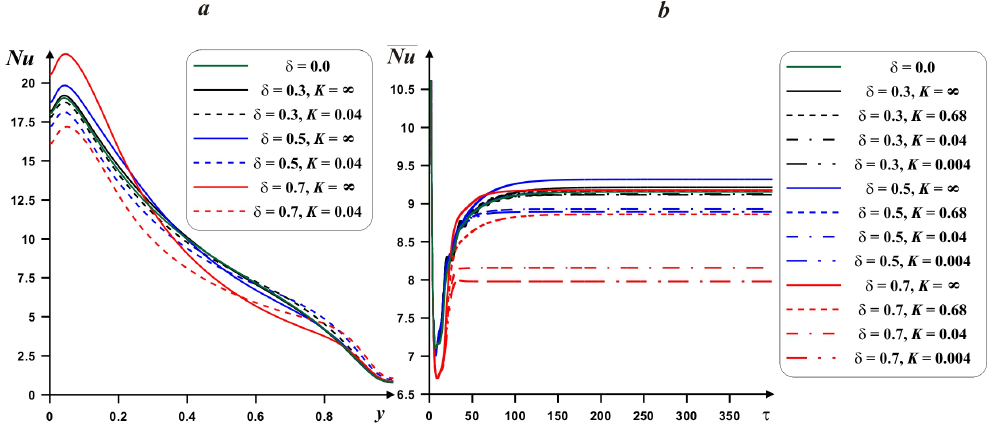
Figure 13. Local Nu profiles ( a ) and time-dependent mean Nu profiles ( b ) for Ra = 10 6 , φ = 0.02 and different δ and K .